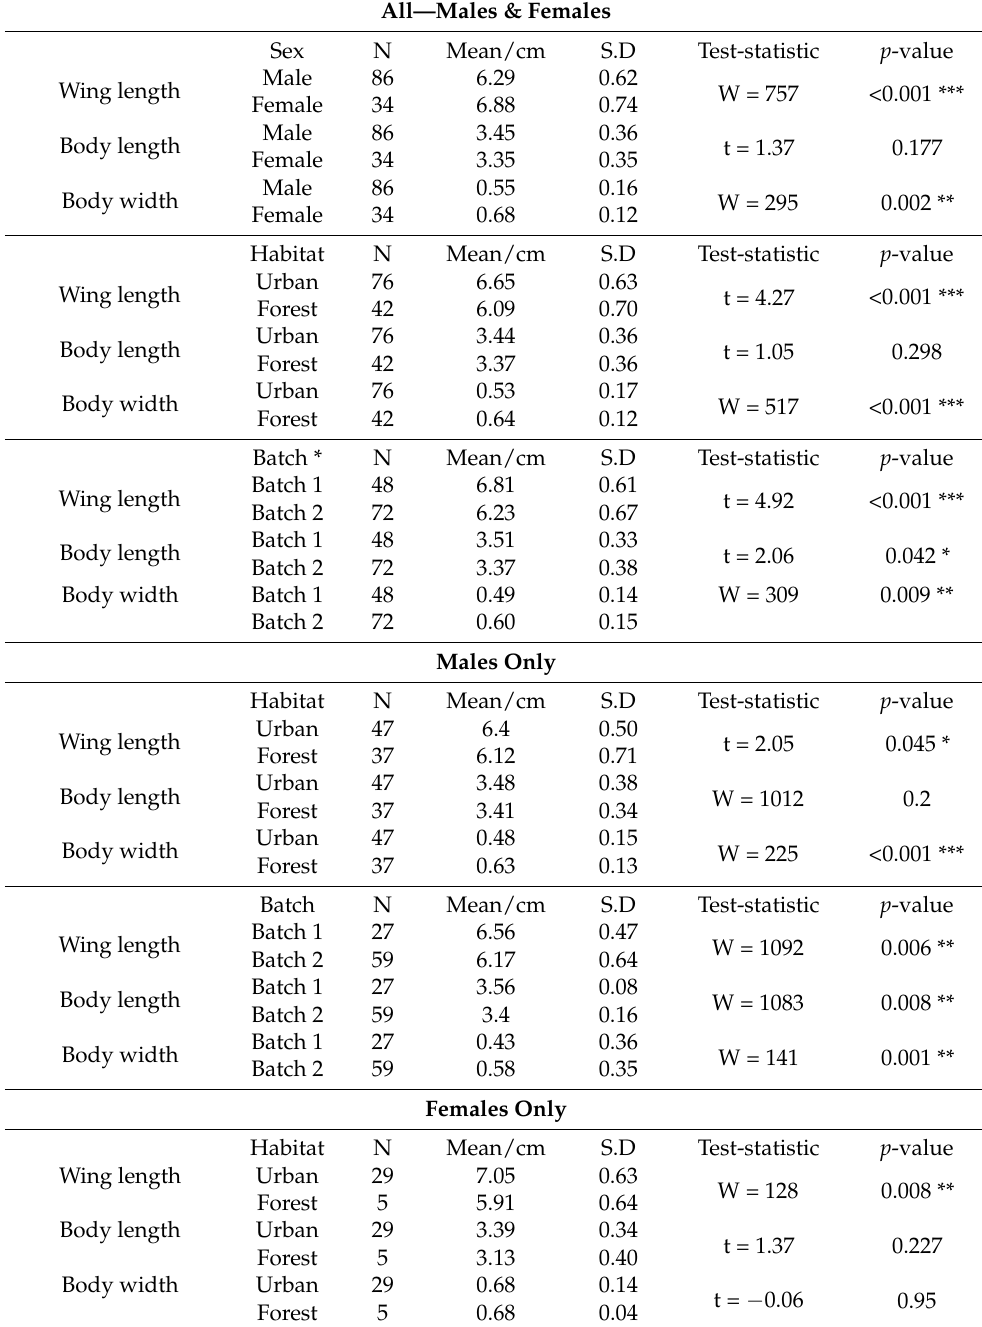
Table 4. Wing length, body length, and body width variation between sexes, batches and habitats (forest, urban areas) in L. zampa. Body length was measured from the head to the end of the abdomen. Body width was measured at the thickest point of the specimen’s abdomen. Wing length was measured from the midpoint of the head to the tip of the most intact wing. ‘t’ value refers to t-test and was used when the datasets were normally distributed. ‘W’ value refers to Wilcoxon signed rank test and was used when the datasets were not normally distributed. Level of significance is marked with asterisk: *** p < 0.001, ** p < 0.01, * p <